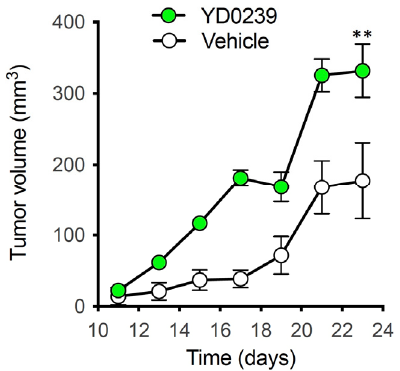
Figure 5. Effects of YD0239 on HCT116 tumor xenograft growth In Vivo. HCT116 tumor-bearing Nu/nu Balb/C mice were treated with either vehicle or YD0239 (6 mg/kg/daily) via s.q. injection once a day for 24 days. Tumor size (volume) was measured transcutaneously with a caliper every 2–3